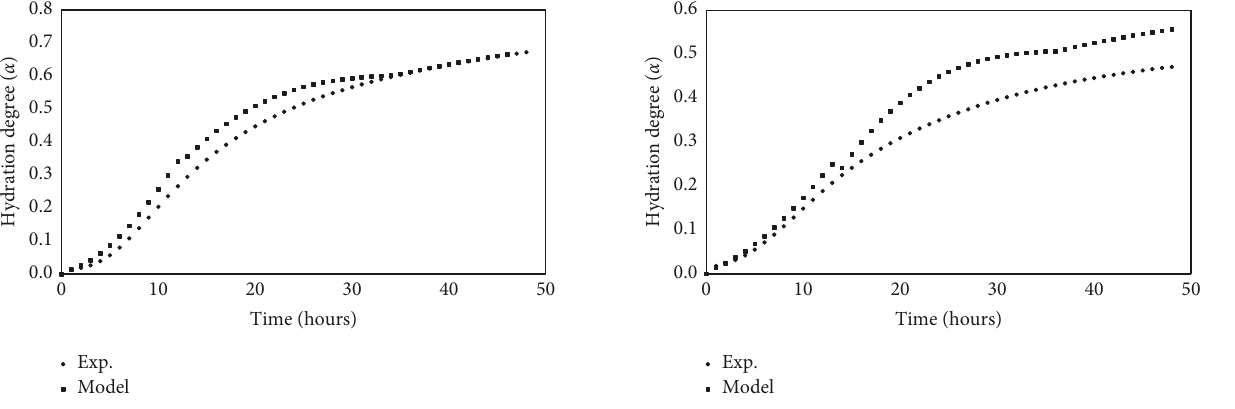
Figure 11: Experimental results of the hydration degree with the assumed kinetic model for sample